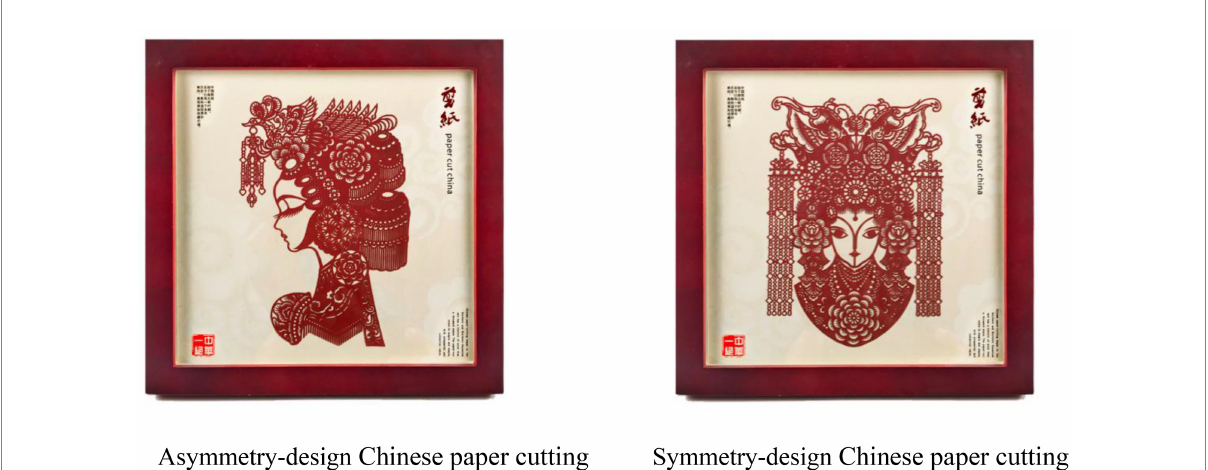
FIGURE 3 Picture of ICH souvenir stimuli used in Study